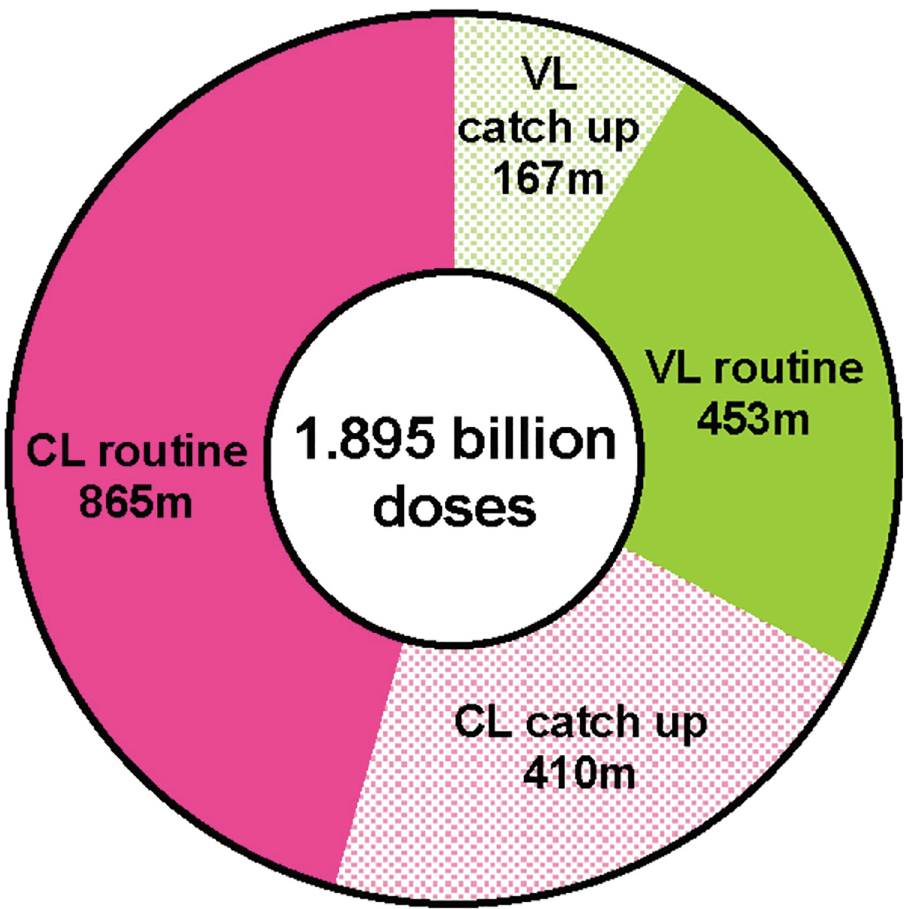
Fig 3. Vaccine demand: total number of doses for the period 2025–2040 stratified by delivery strategy (routine immunisation and catch-up campaign at start) and by indication (VL and CL).